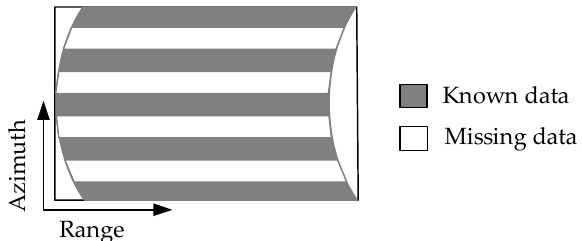
Figure 2. Schematic diagram of two-dimensional (2D) echo with azimuth complete sampling data.